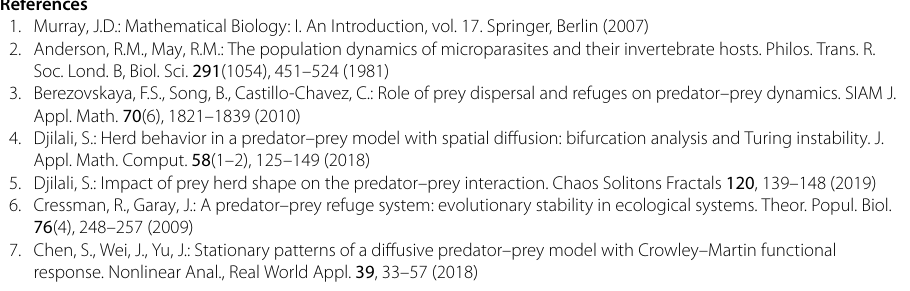
Acknowledgements Not